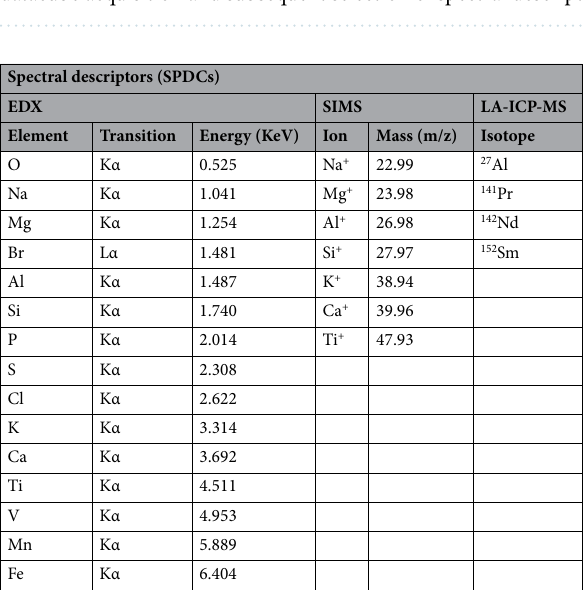
Figure 2. Basic scheme of the hyperspectral imaging acquisition and the methodology for the multisensor datacube acquisition and subsequent selection of spectral descriptors.